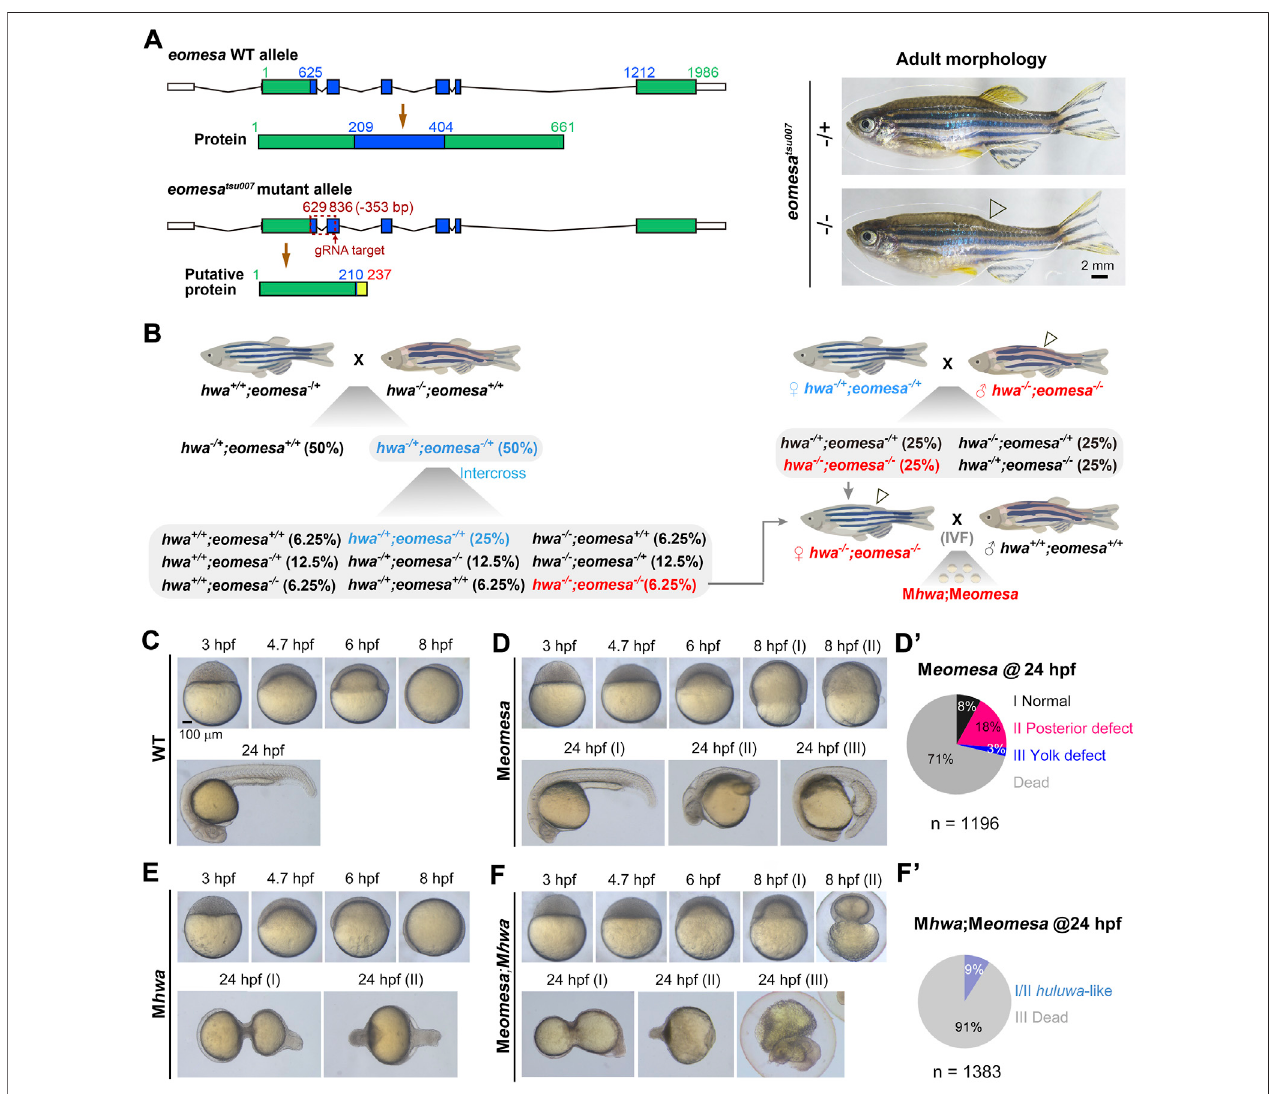
FIGURE1| Phenotypesofdifferentmutantsatvariousstages. (A) Generationof eomesa tsu007 mutantallele.Left:genomicstructuresandputativecodingproducts of eomesa WTalleleandtsu007allele.Theexonswerecoloredandpositionsofnucleotidesandaminoacidswereindicated.Themutantallelecarriesa353-bpdeletion. Right:morphologyof eomesa +/tsu007 (heterozygote)and eomesa tsu007/tsu007 (zygoticmutant)adults.Notethattheposteriordorsal fi n(indicatedbyanhollowarrowhead) is absent in mutant adult. (B) Scheme of generation of M hwa; M eomesa double mutants. Zygotic genotypes were indicated. Z hwa − / − ; Z eomesa − / − homozygous femaleadultscouldnotovulatenaturally,andeggssqueezedfromthese fi shwereusedfor invitro fertilization(IVF)usingspermssqueezedfromwildtypemales(Z hwa +/+ ; Z eomesa +/+ ). (C) Wildtype (WT) embryos at indicated stages. (D,D ’ ) M eomesa mutants. Mutant embryos exhibited variable phenotypes at 8 hpf and 24 hpf, and the ratios of 24-hpf mutants categorized into different classes (I-III), which were derived from several homozygous females, were shown in (D ’ ) . (E) M hwa mutants at indicated stages. (F,F ’ ) M eomesa; M hwa double mutants. The ratios of embryos with different phenotypes at 24 hpf were shown in (F ’ ) . Embryos were laterally positioned when the dorsal or tail was recognizable. The scale bar in (C) was also applied to (D – F).